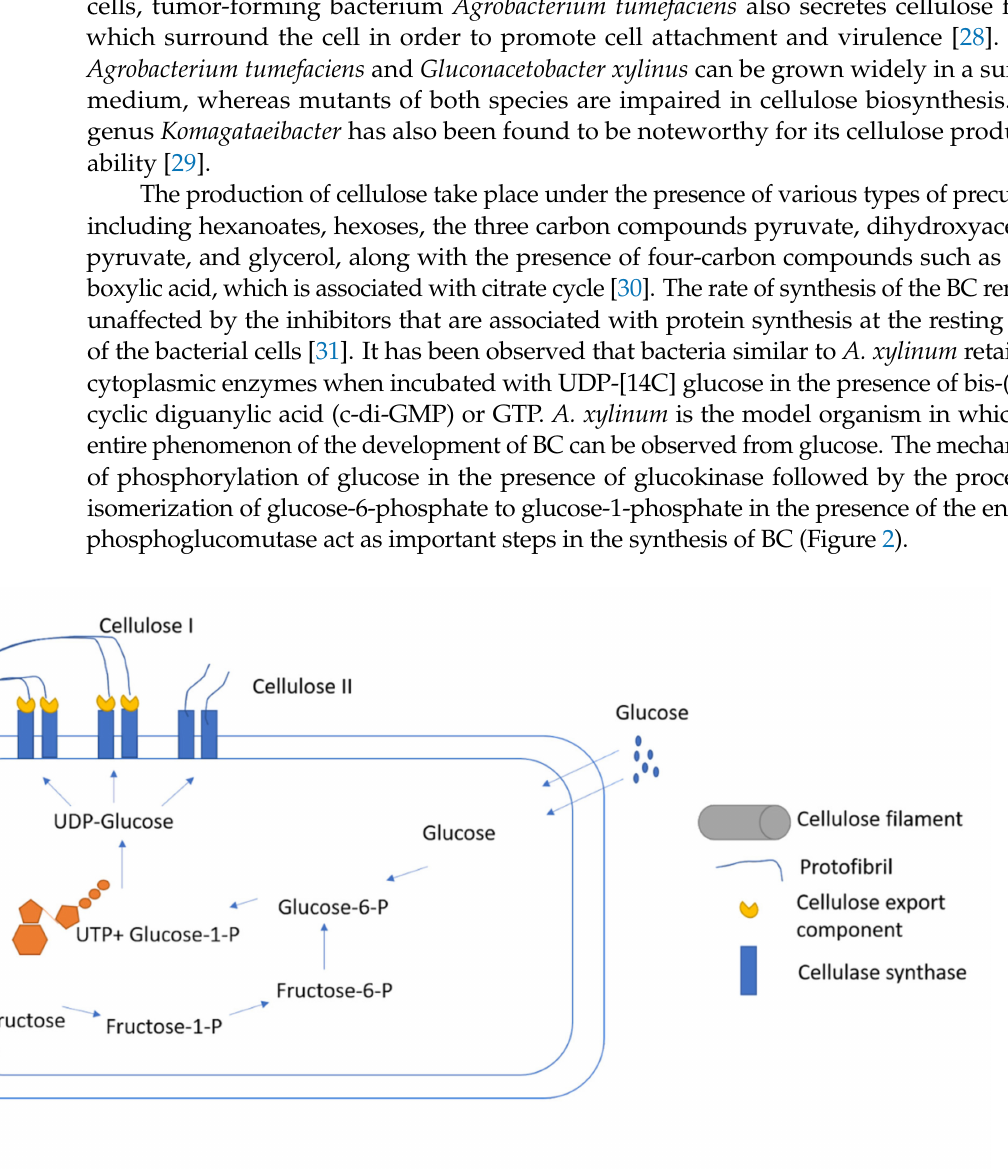
Figure 2. Biosynthesis of cellulose I and cellulose II from glucose and fructose in bacterial